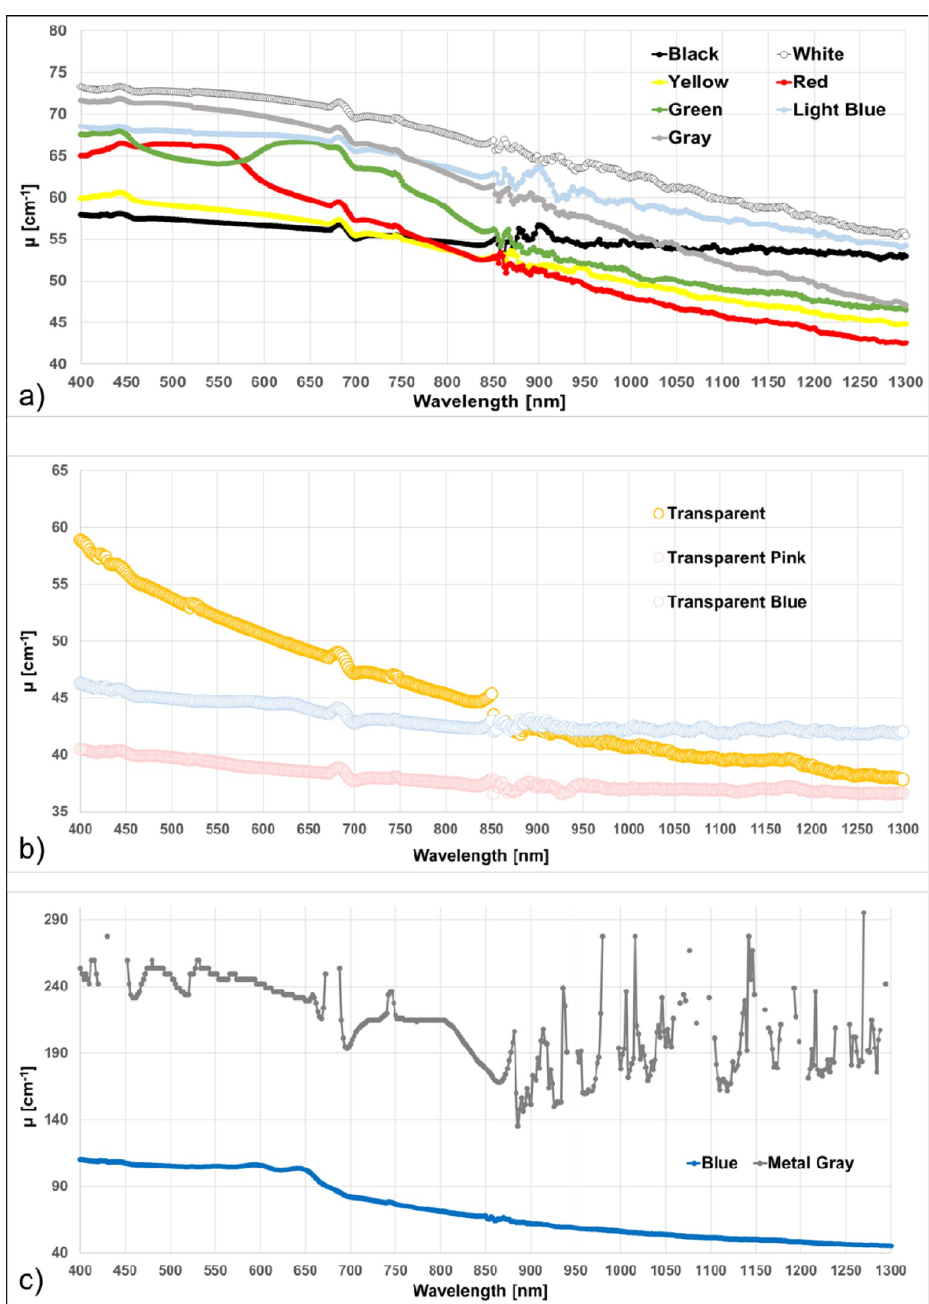
Fig 3. Extinction coefficient μ spectra in the wavelength range 400–1300 nm for PLA filament with different colors from the same producer (MDKOEM). a) opaque colors; b) transparent colors; c) metal gray and blue.